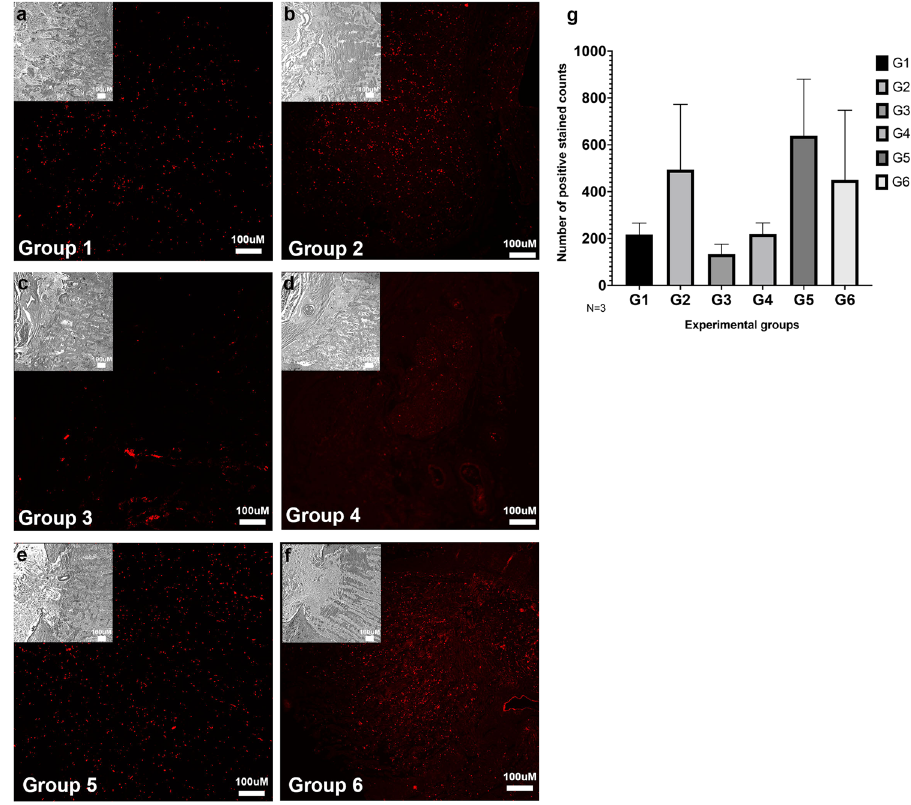
cross sections and ( g ) quanti fi cation of all CTB positive cells within all 6 groups. a – f 100x magni fi cation; CTB = red, N = 3. Data are presented as mean ± standard error of the mean and P < 0.05 was considered statistically signi fi